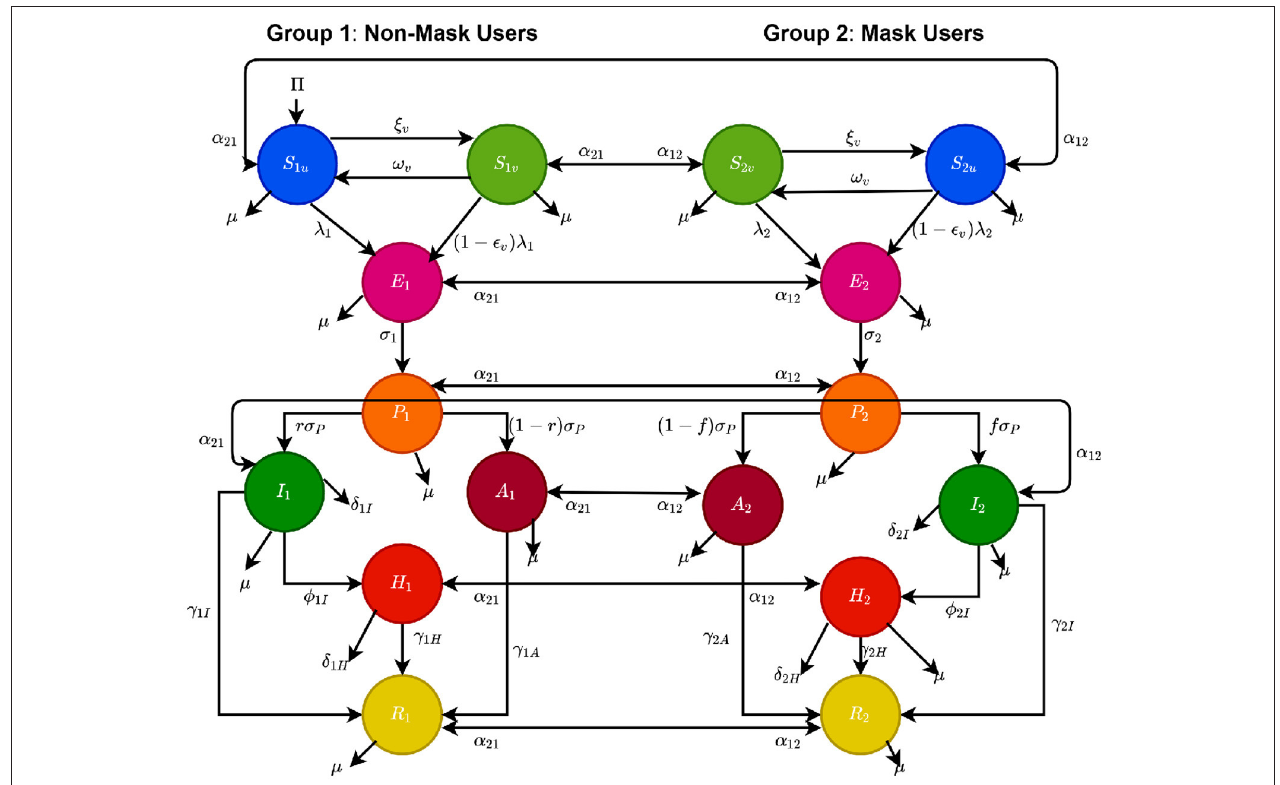
FIGURE 1 | Flow diagram of the model { (2.5),(2.6) }